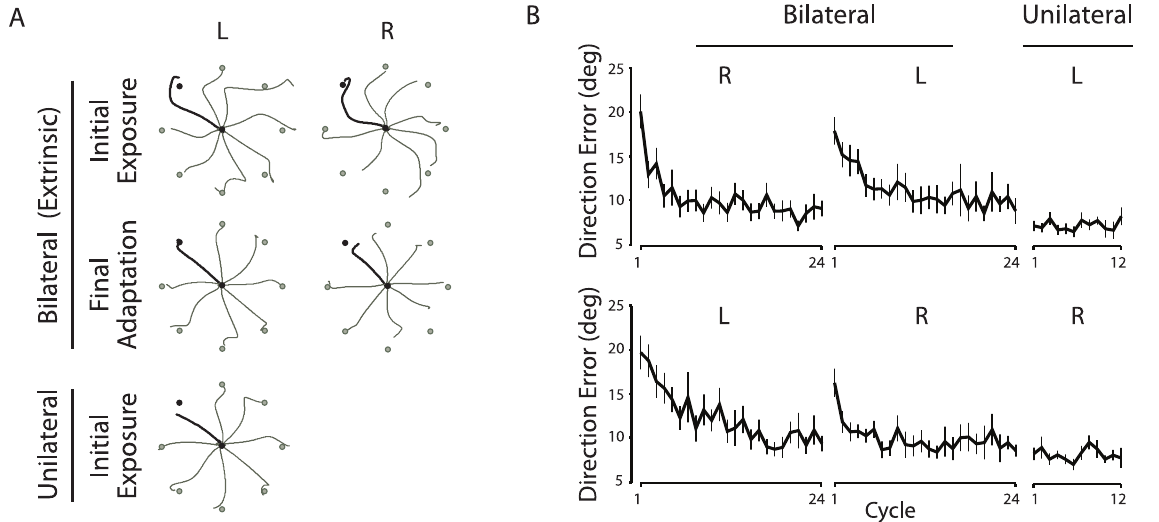
Figure 2. Reaching performance observed when the force field was provided to both arms during the bilateral session. A, Hand-paths obtained from a representative subject who reached toward extrinsically consistent targets during the bilateral session and used the left arm during the unilateral session. Hand-paths represent the first (rows 1, 3) or the last (row 2) eight consecutive trials in each session. Pairs (L and R) of black lines in the bilateral session indicate target directions presented simultaneously for bilateral performance. L above the hand-paths indicates left arm, R right arm. B, Mean direction errors. Every data point shown on X axis represents the average of 8 consecutive trials (cycle) across subjects (mean 6 SE). Direction errors for the subjects who performed the unilateral task with the left (top) or the right (bottom) arm are shown separately (data collapsed across two target-consistency conditions due to lack of significant differences).